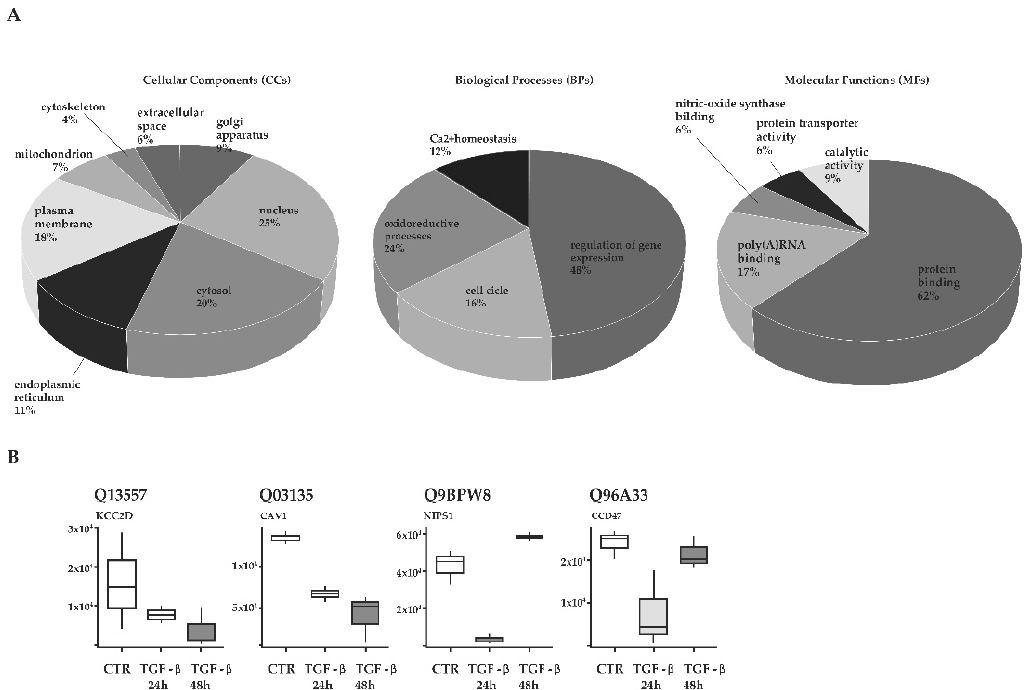
Figure 3. ( A ) GO enrichment analysis of cholangiocytes was retrieved using DAVID. The most enriched GO terms in biological processes (BPs), molecular functions (MFs) and cellular components (CCs) are presented. ( B ) Box plot reporting protein abundances for selected proteins of biological interest in cholangiocyte pathophysiology.